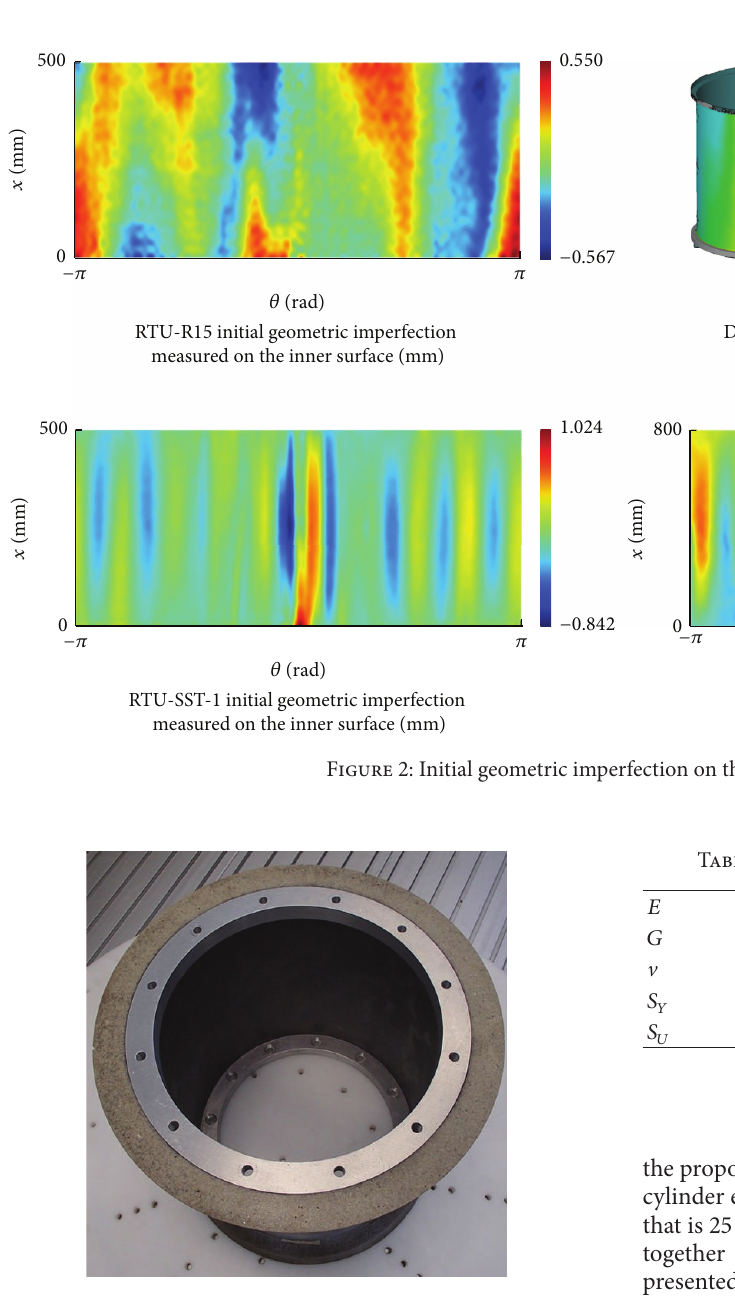
Figure 3: Boundary conditions on top and bottom edges.